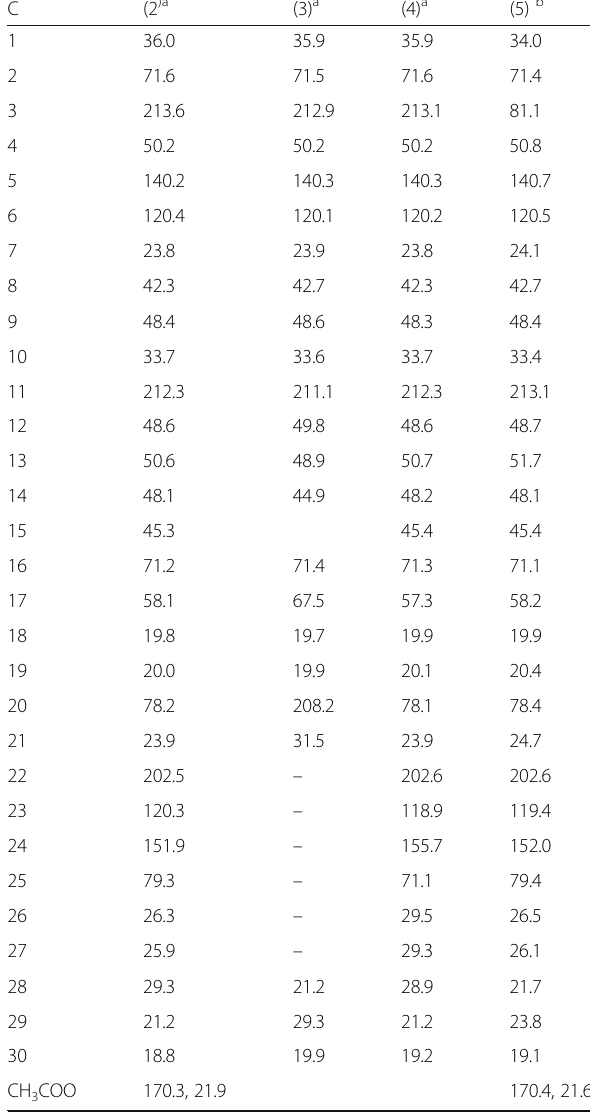
Table 2 13 C-NMR spectral data for compounds 2, 3, 4 and 5 in CDCl